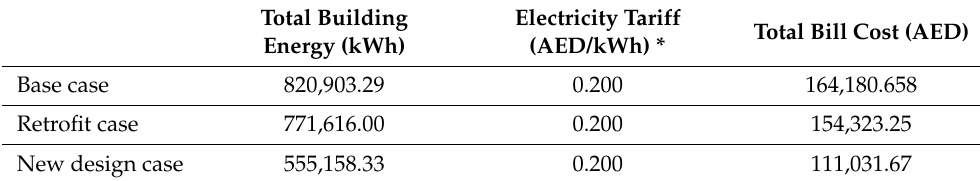
Figure 21. The energy model of ( a ) retrofitted building, ( b ) new building design. Table 4. Total bill cost of the three scenarios using the simulated energy